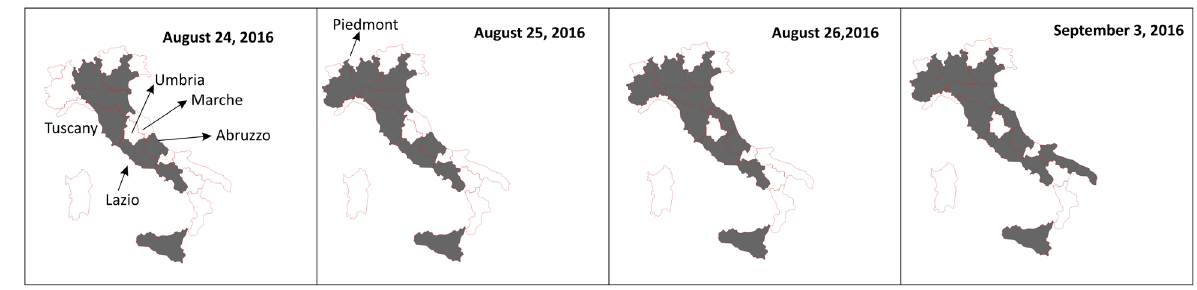
Fig. 4 2016 Central Italy earthquake. Spread of ATR internet searches over the Italian regions from August 24 to September